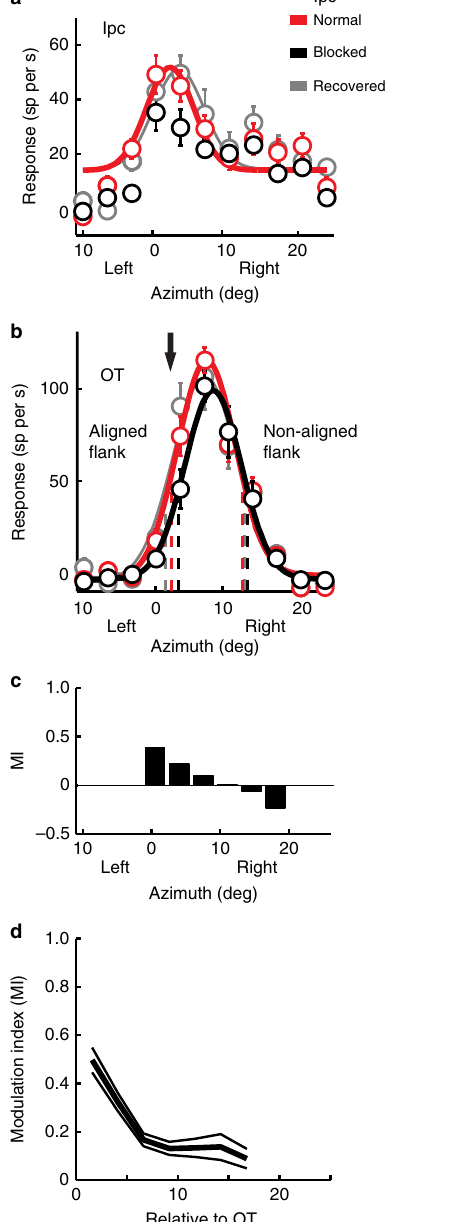
Figure 4 | Effect of Ipc blockade on spatial tuning at non-aligned sites in the OT. ( a ) Data from a multi-unit recording at the Ipc injection site. ( b ) Data from a simultaneously recorded single OT unit at a non-aligned site in the OT. Conventions are the same as in Fig. 2. ( c ) Response modulation index calculated from the Gaussian fits shown in b . ( d ) Population average modulation index (MI) and s.e.m. resulting from Ipc blockade for OT units from non-aligned pairs ( n ¼ 19). For each location, MI values were calculated only for those OT units that gave a significant response before blockade (Methods). The data are plotted relative to the Ipc-aligned border of the OT VRF (Methods). NATURE COMMUNICATIONS|7:13472|DOI: